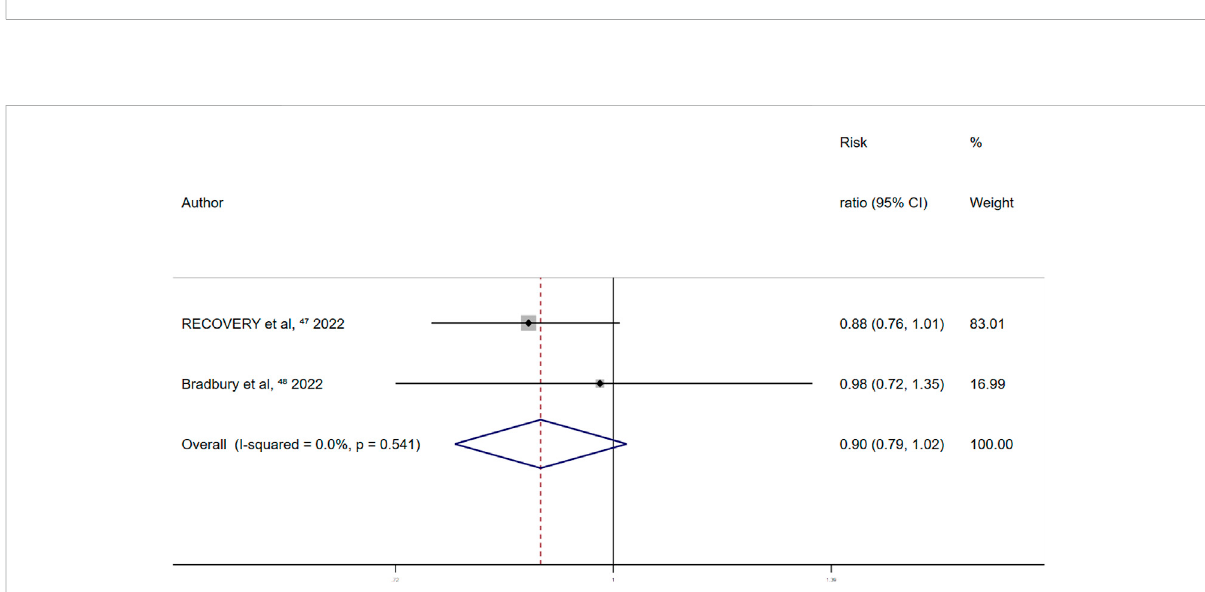
FIGURE 8 Summary hazard ratio of thrombotic events for aspirin use in randomized controlled